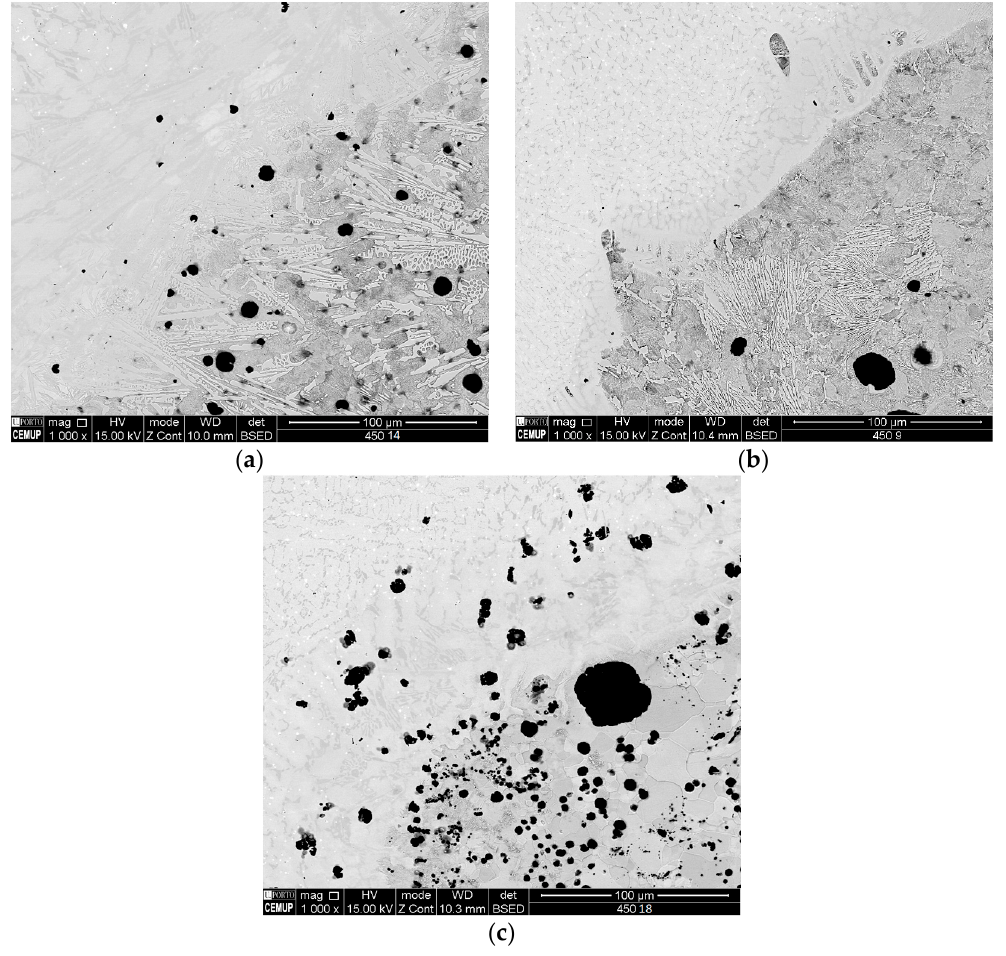
Figure 12. SEM analysis of samples at 1000× magnification with 4% Nital etching: ( a ) sample